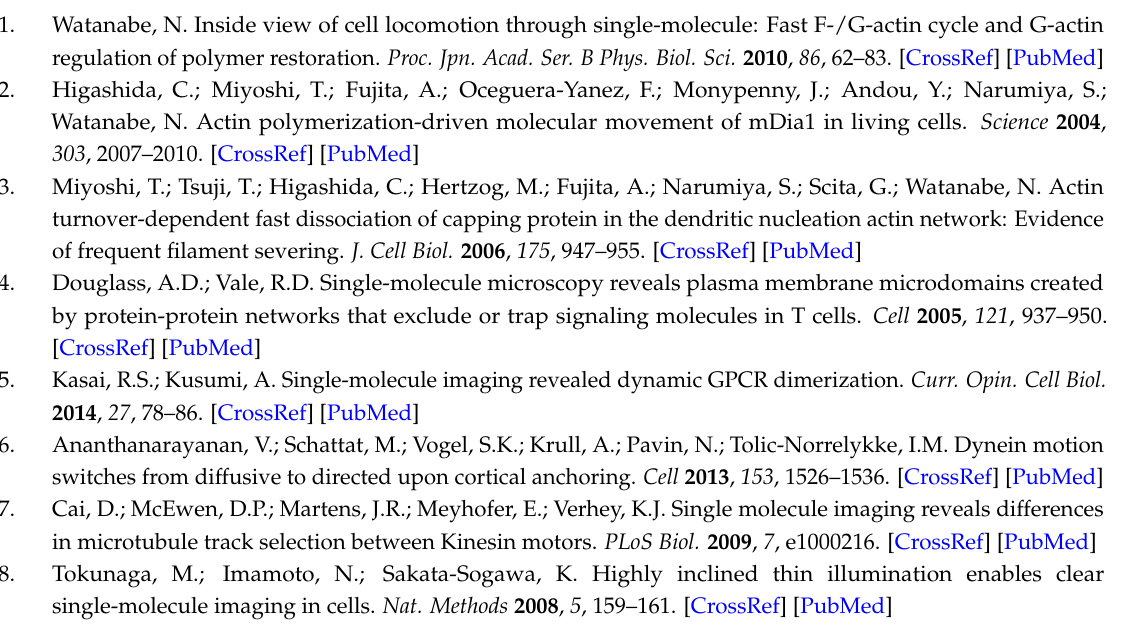
Figure S1: Images of DL550-actin SiMS in cell periphery of XTC cell (left) or A6 cell (right) acquired under the acquisition condition for DL550-actin SiMS described in the legend of Figure 3B. Bar = 5 µ m, Video S1: Intracellular photostability of fluorescent dye-labeled actin probes (Figure 1), Video S2: Photostability of CF680R-actin under attenuated xenon excitation (Figure 2A), Video S3: Time-lapse movie of SiMS of CF680R-actin in AJ of A6 cells (Figure